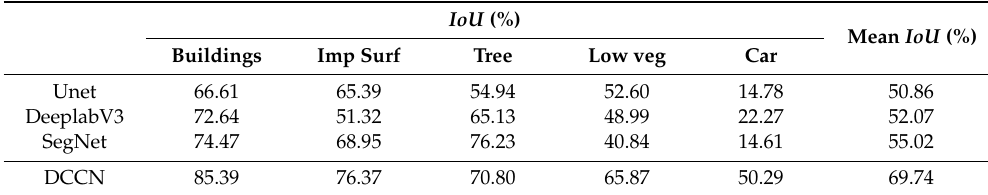
Table 6. IoU results of different methods with the Vaihingen dataset.